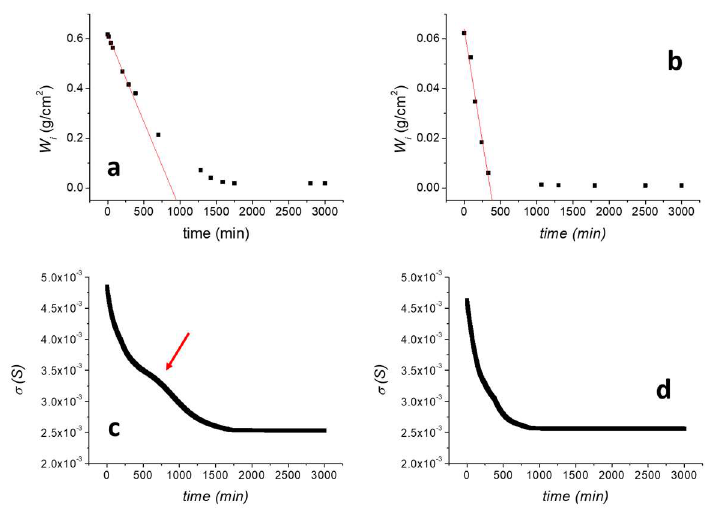
Figure 4. ( a ) Water capillary absorption curve of untreated TUFF specimen. ( b ) Surface conductivity profile recorded at the sides of the MMT/rGO sensor applying a 3 V voltage during the water capillary absorption test.